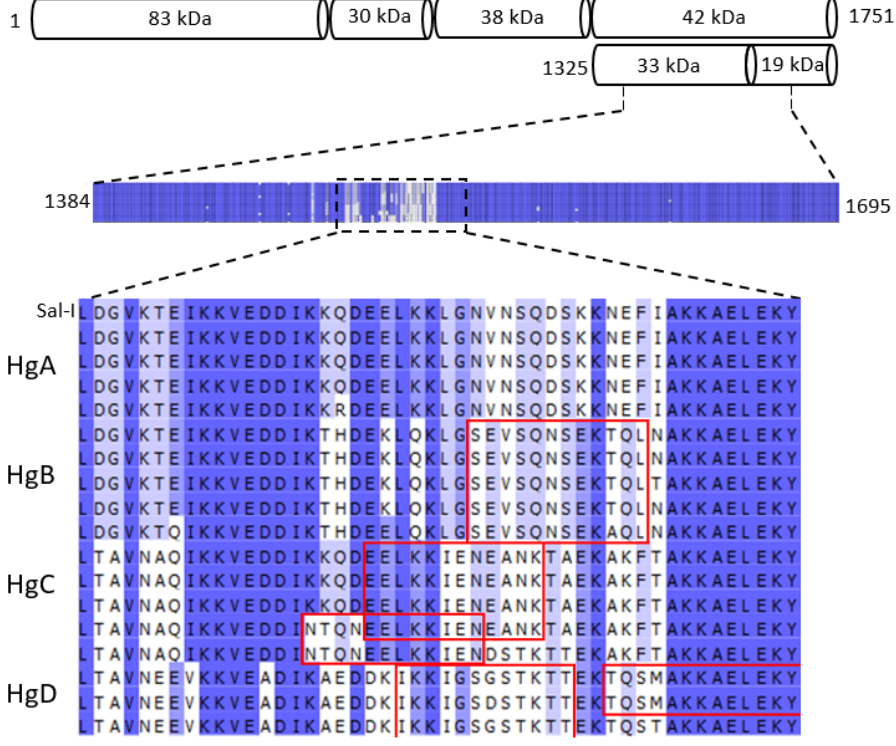
Figure 4. The P. vivax MSP1-42 kDa highly variable peptide segment (amino acids 1489–1536) and the predicted B-cell epitopes. Different B-cell epitopes were predicted for each haplogroup with the Bcpred web server (in the red boxes). The epitope prediction of ≥ 12 consecutive amino acids was obtained by using 85% specificity. The Sal-I sequence was similar to h1 from southern Mexico.